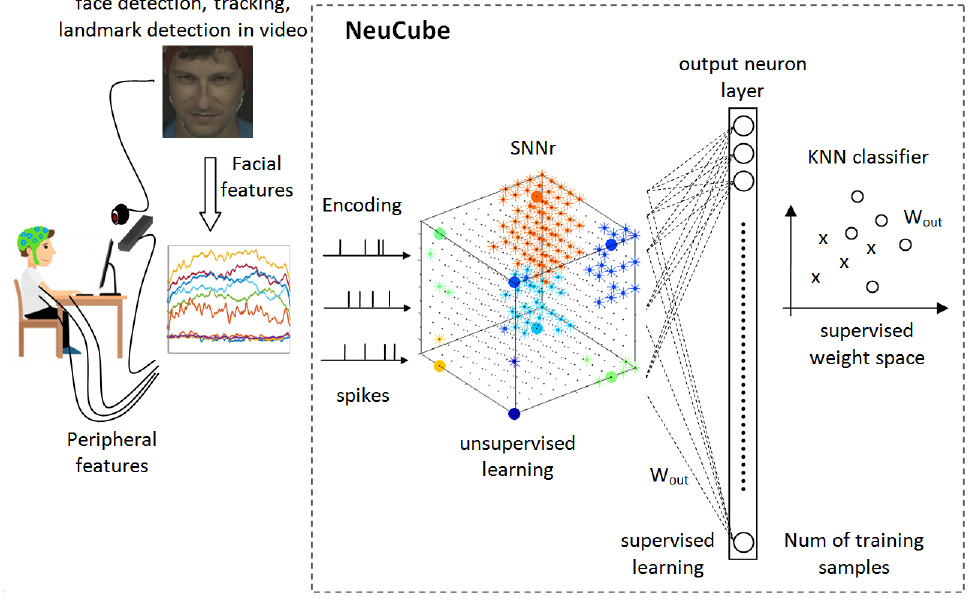
Figure 6. Proposed method for emotion valence classification using